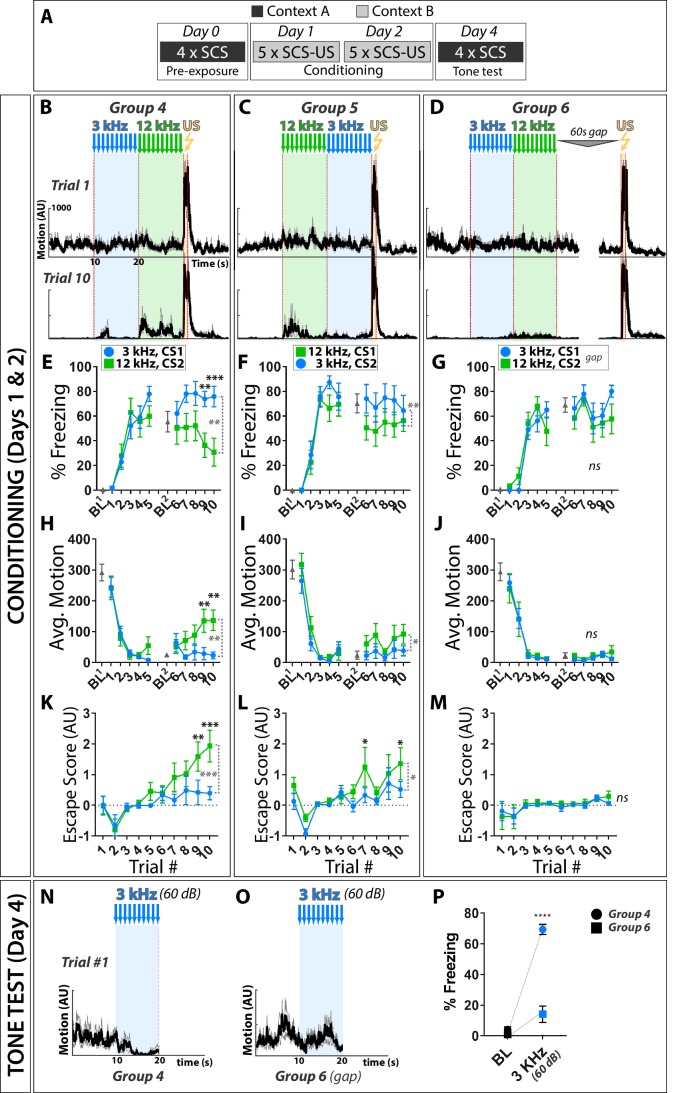
Active fear behaviors are more potently elicited by 12 kHz than 3 kHz stimuli during pure tone SCS conditioning.(A) Contribution of CS audio frequency, order presented relative to US, and pairing were assessed by conditioning with a SCS composed of 3 and 12 kHz pure tones; conditioning was done as in Figure 1A. (B–D) Motion indices (mean ± SEM) show locomotor responses to stimuli (3 kHz pips, blue; 12 kHz pips, green; 0.9 mA footshock, yellow) for trials 1 (Day 1, top) and 10 (Day 2, bottom). (E–G) Percent time spent freezing. (H–J) Average motion. (K–M) Escape score. CS order and pairing: group 4 (B,E,H,K: CS1 = 3 kHz, CS2 = 12 kHz; n = 10), group 5 (C,F,I,L: CS1 = 12 kHz, CS2 = 3 kHz; n = 10), and group 3 (D,G,J,M: CS1 = 3 kHz, CS2 = 12 kHz, unpaired; n = 10). (N–P) Tone tests established that lack of active responses to the 75 dB 3 kHz CS was not due to it being inaudible, as paired mice exhibited robust freezing to this stimulus when presented at an even lower SPL (60 dB) outside of the conditioning context. Black asterisks indicate significant difference between groups for a given trial. Dashed vertical gray brackets indicate significant main effect of CS type. Error bars indicate the SEM.Figure 4—source data 1.Raw data used to generate freezing, motion, escape plots and traces.Figure 4—source data 2.All statistical tests and significant comparisons with F and P values.